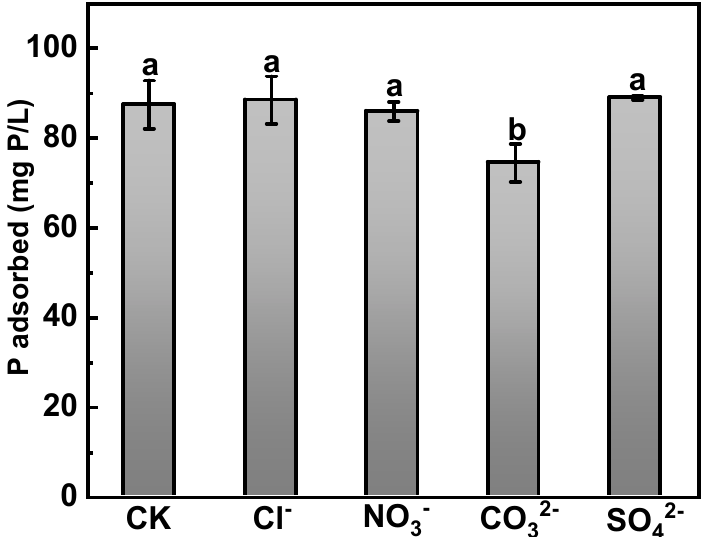
Figure 3. Effect of coexisting anions on phosphate sorption (Dosage: 0.05 g; Temperature: 25 ◦ C; Time: 24 h; Initial phosphorus concentration: 150 mg P/L). The letters a, b represent the results of significance analysis of variance.